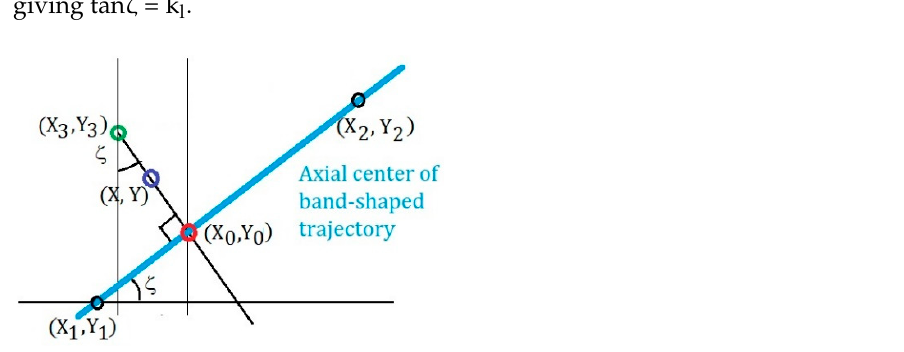
Figure 17. Sunbeam coordinates on the pond surface images used to calculate the integrated data for image analyses.